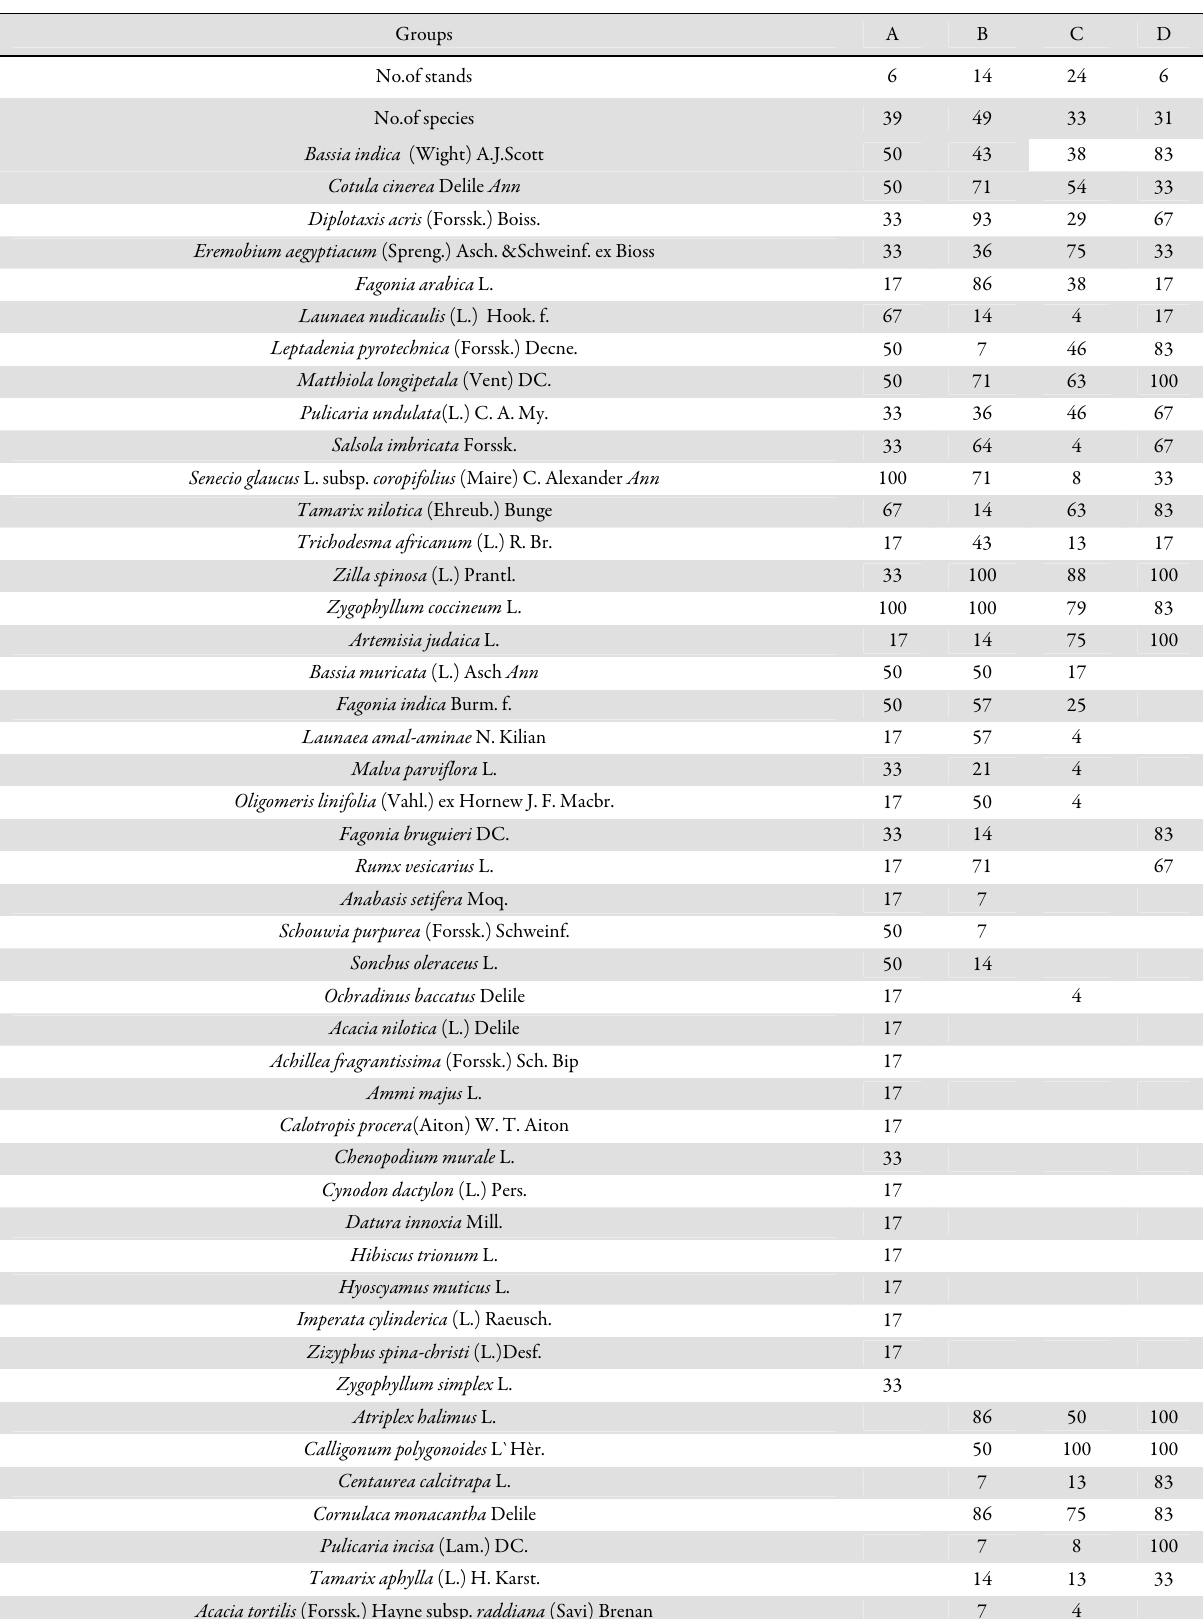
Tab. 2. Floristic composition in the vegetation groups of Wadi El-Assuity and Wadi Habib. Figures in bold are species with highest presence